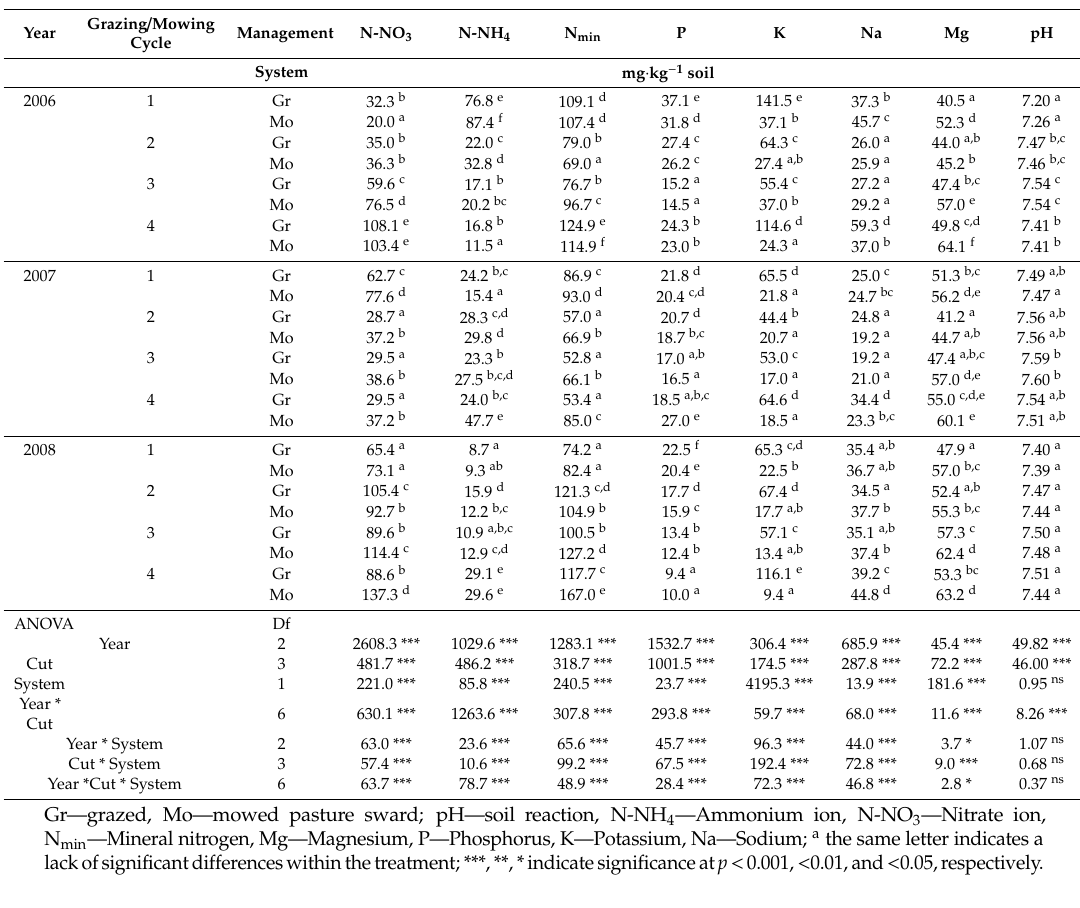
Table 3. Soil chemical properties in pasture soil under two di ff erent management systems and subjected to grazing / mowing cycles, during a three-year period.